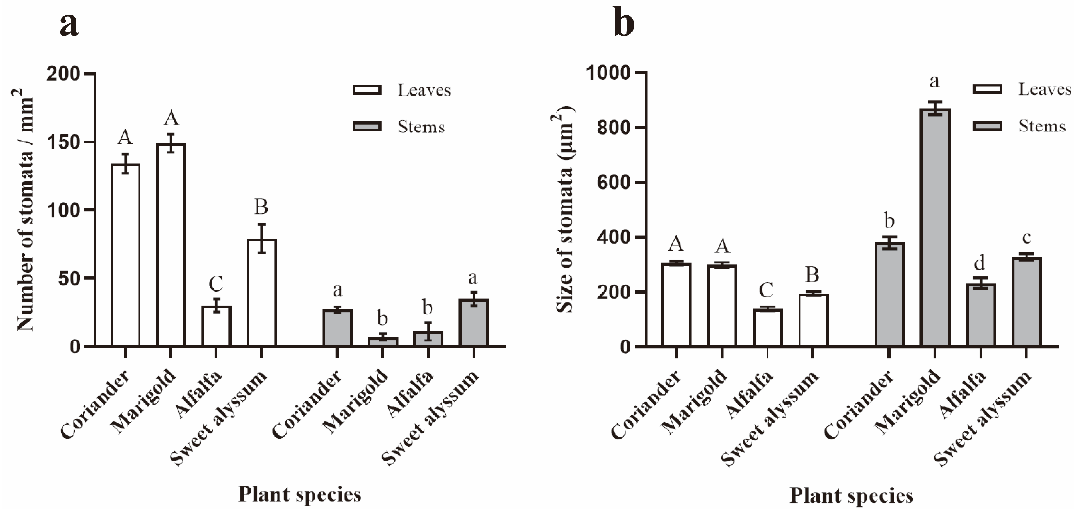
Figure 6. A comparison of the stomatal densities ( a ) and size ( b ) of leaves and stems among four plant species ( α = 0.05; ANOVA). ( a ) Stomatal densities, sample sizes for each plant species: leaves n = 5–11; stems n = 3 for alfalfa, n = 7–10 for other three plant species. ( b ) Stomatal densities. Sample sizes for each plant species: leaves n = 23–25, stems n = 8–20. Values are mean ± SE. Means indicated by the same letter are not significantly different according to LSD test.